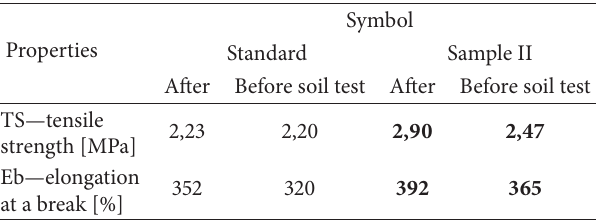
Table 6: The influence of keratin on the mechanical properties of NBR vulcanizates after and before soil